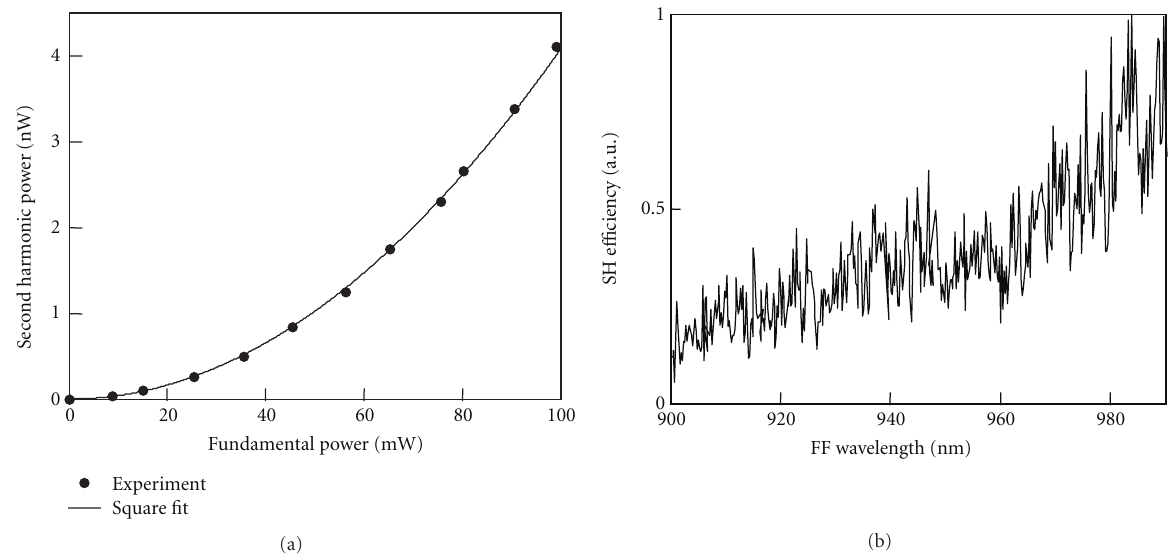
Figure 9: (a) SH generated via rQPM versus FF input power at λ FF = 929 . 66nm; (b) SHG conversion e ffi ciency versus FF wavelength.